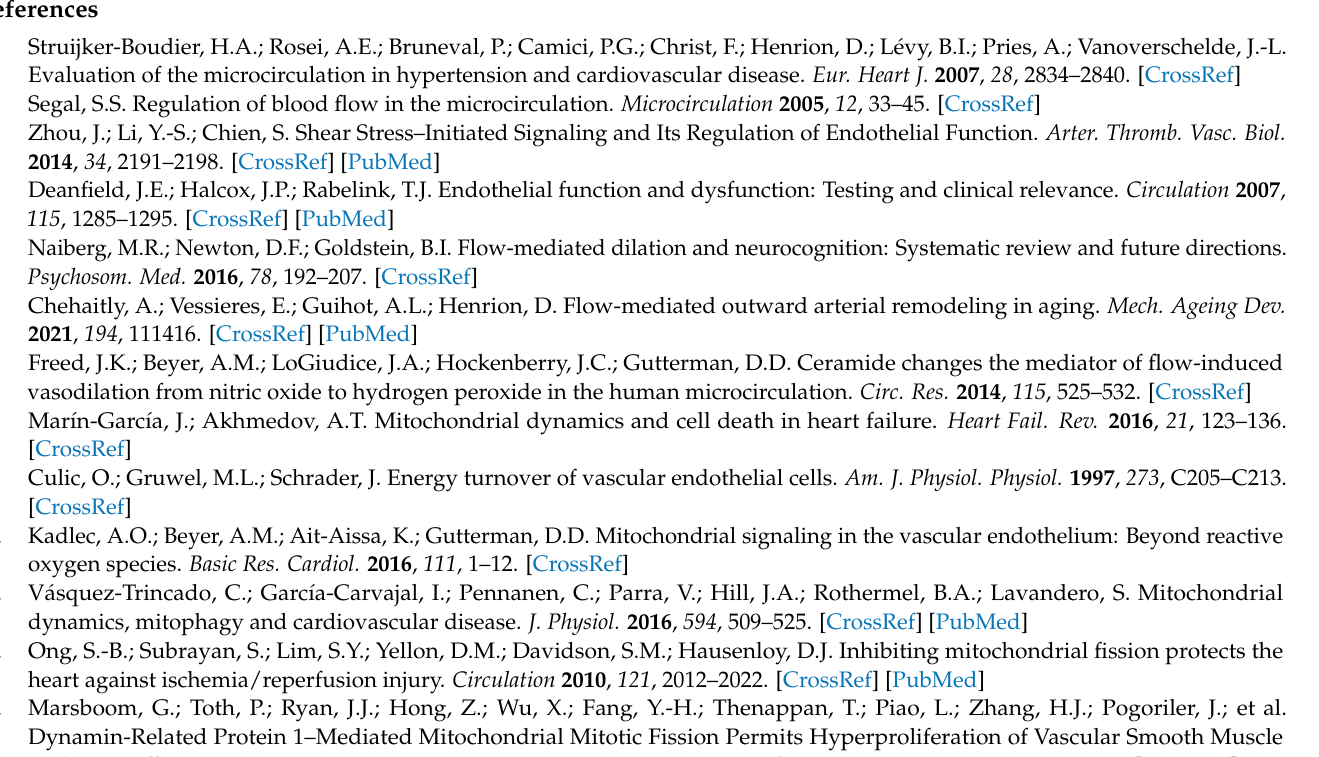
HUVECs. Figure S2: Positive and negative controls of ECs migration. Figure S3: Whole blots corresponding to the graphs shown in Figure 2A,C,F,G. Figure S4: Whole blots corresponding to the graphs shown in Figure 2B,D,E,H. Figure S5: Validation of Opa1 extinction in mesenteric artery endothelial cells isolated from EC-Opa1 or EC-WT mice. Figure S6: Validation of Opa1 extinction in mesenteric artery smooth muscle cells isolated from EC-Opa1 or EC-WT